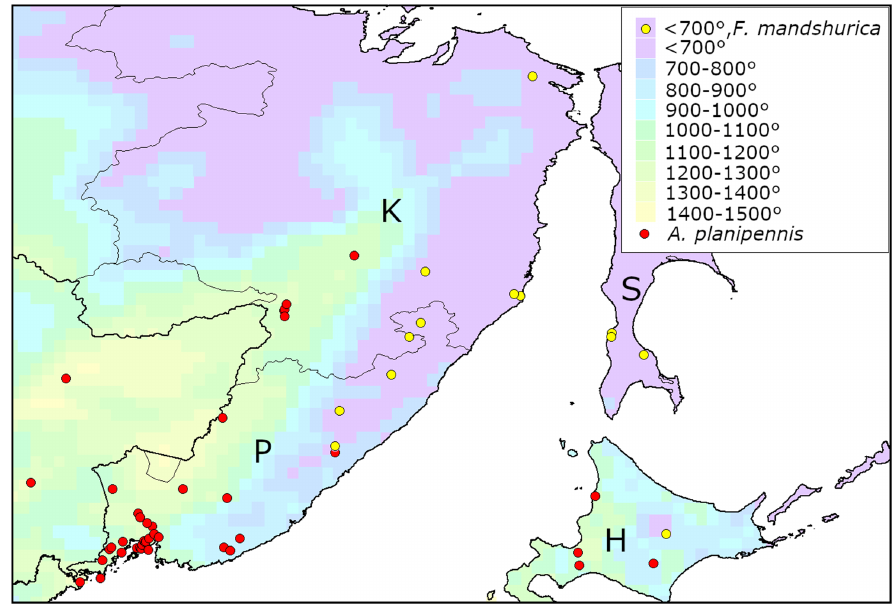
Figure 4. Distribution of Agrilus planipennis and its host plant Fraxinus mandshurica in the northern part of A. planipennis native range in Asia. Mean AGDD 10 per year in 2003–2020 is indicated with colours (see the legend). Sources of the information on occurrences: A. planipennis —recent review of the native range [3], Fraxinus mandshurica —Global Biodiversity Information Facility [29]. Only localities of F. mandshurica in the grid squares with AGDD 10 less than 700° are shown.